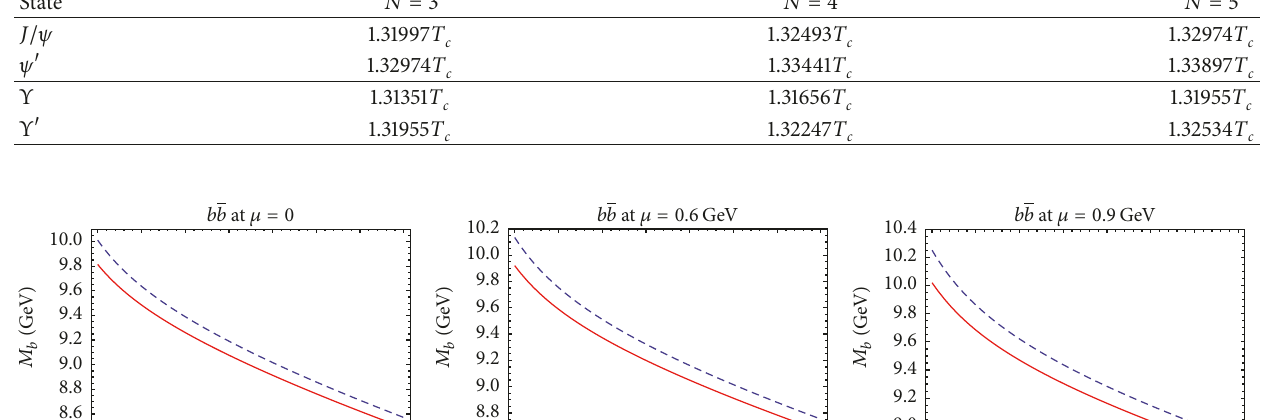
Table 1: The dissociation temperature ( T at 𝜇 = 0.